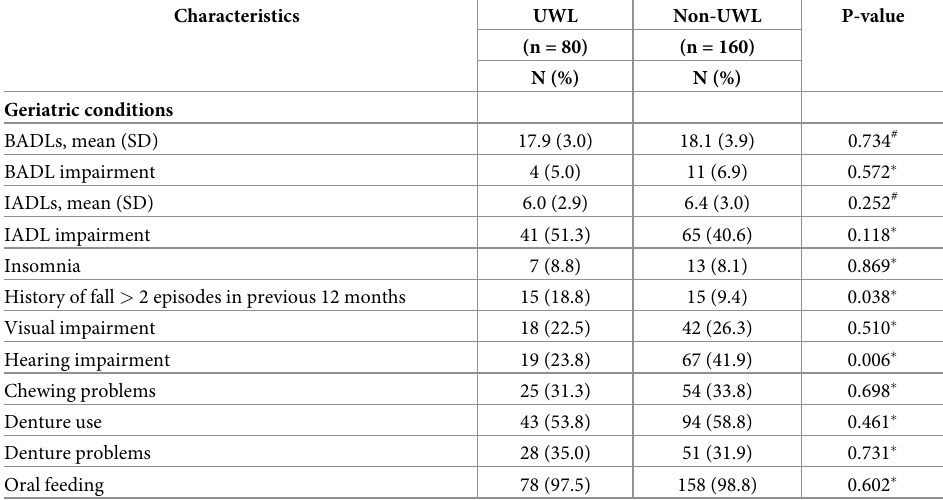
Table 3. Geriatric conditions among older patients in the geriatric outpatient